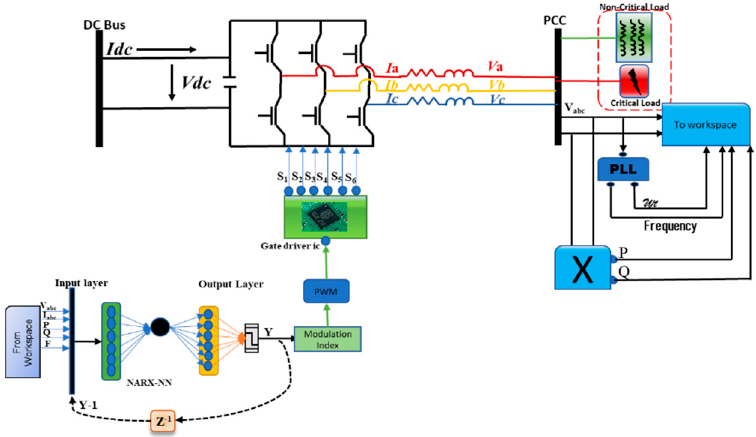
Figure 1. Proposed